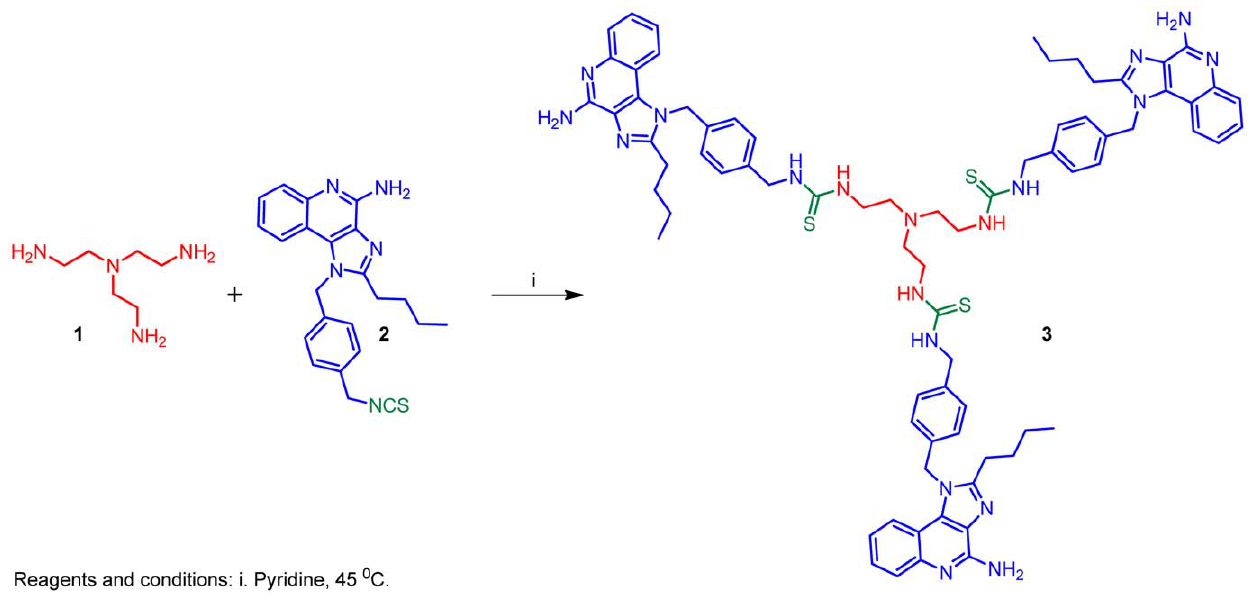
Figure 1. Synthesis of trimeric imidazoquinoline dendrimer 3.